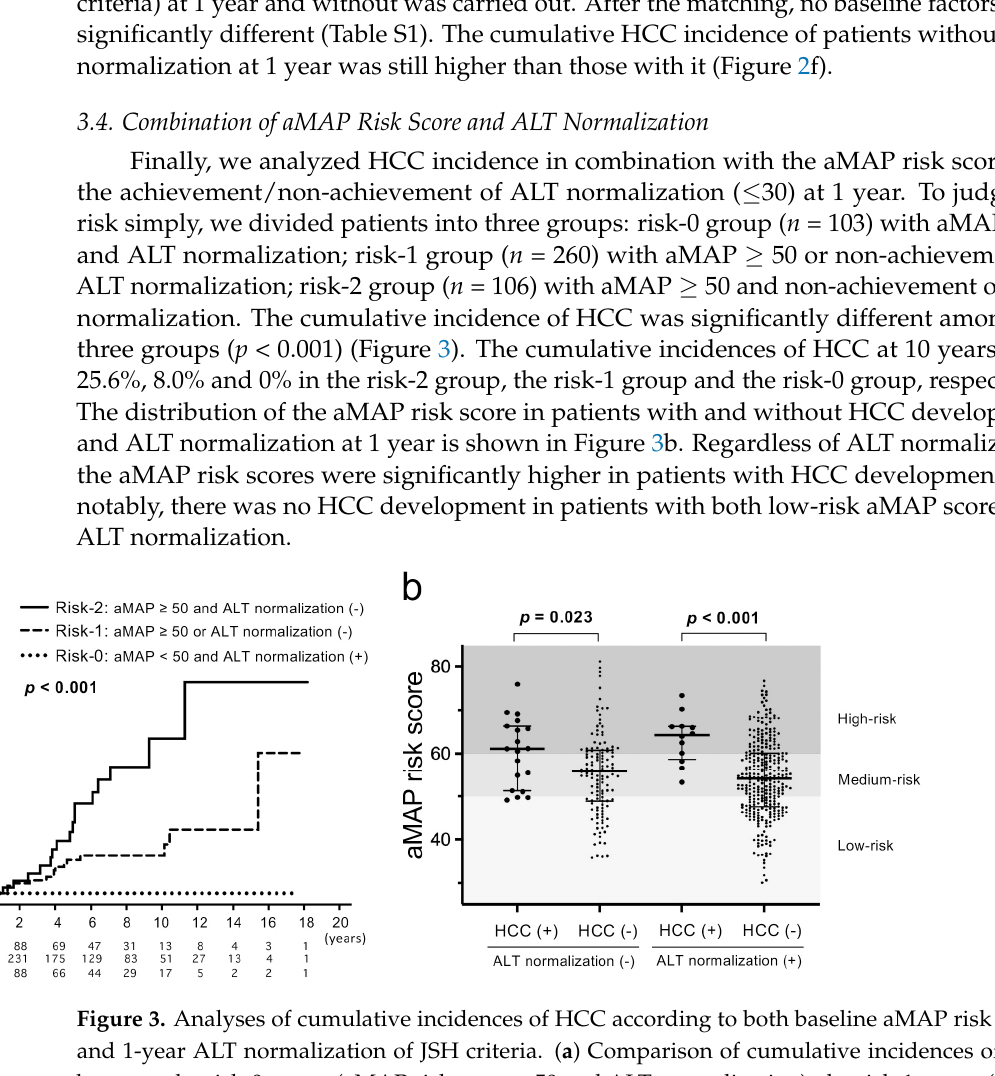
Table 4. Univariate and multivariate logistic regression analysis of baseline factors associated with non-achievement of ALT normalization (JSH criteria) at 1 year.